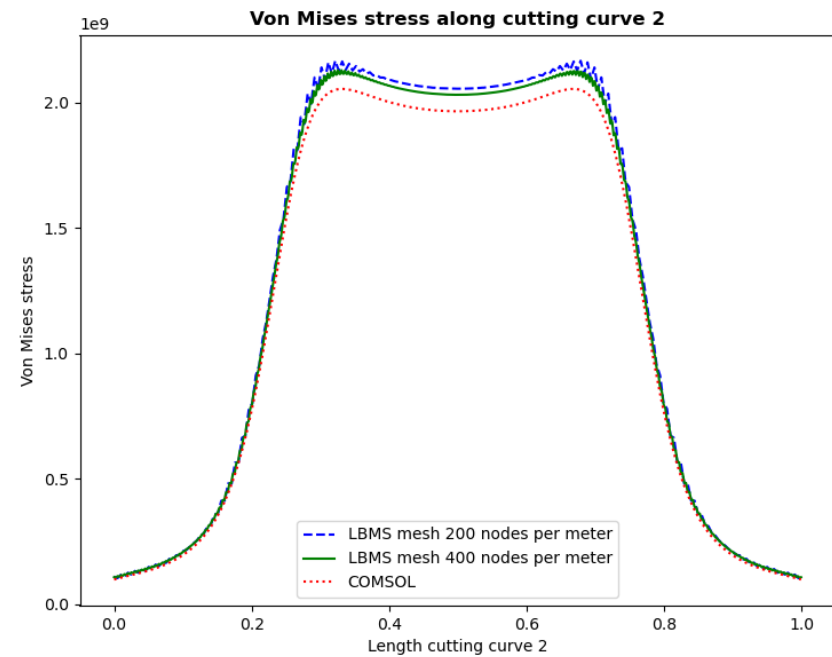
Figure A1. Von Mises stress along cutting curve C 2 for case E = 200 GPa, ν = 0.15.